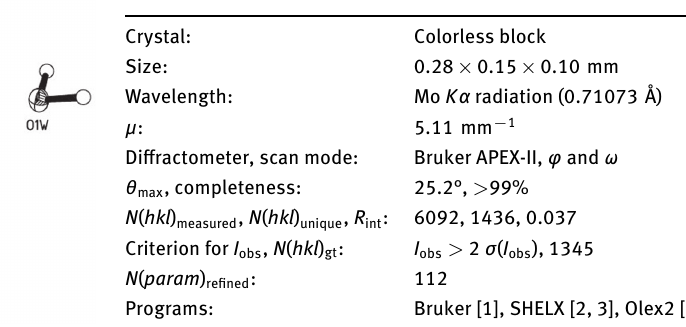
Table 1: Data collection and handling.